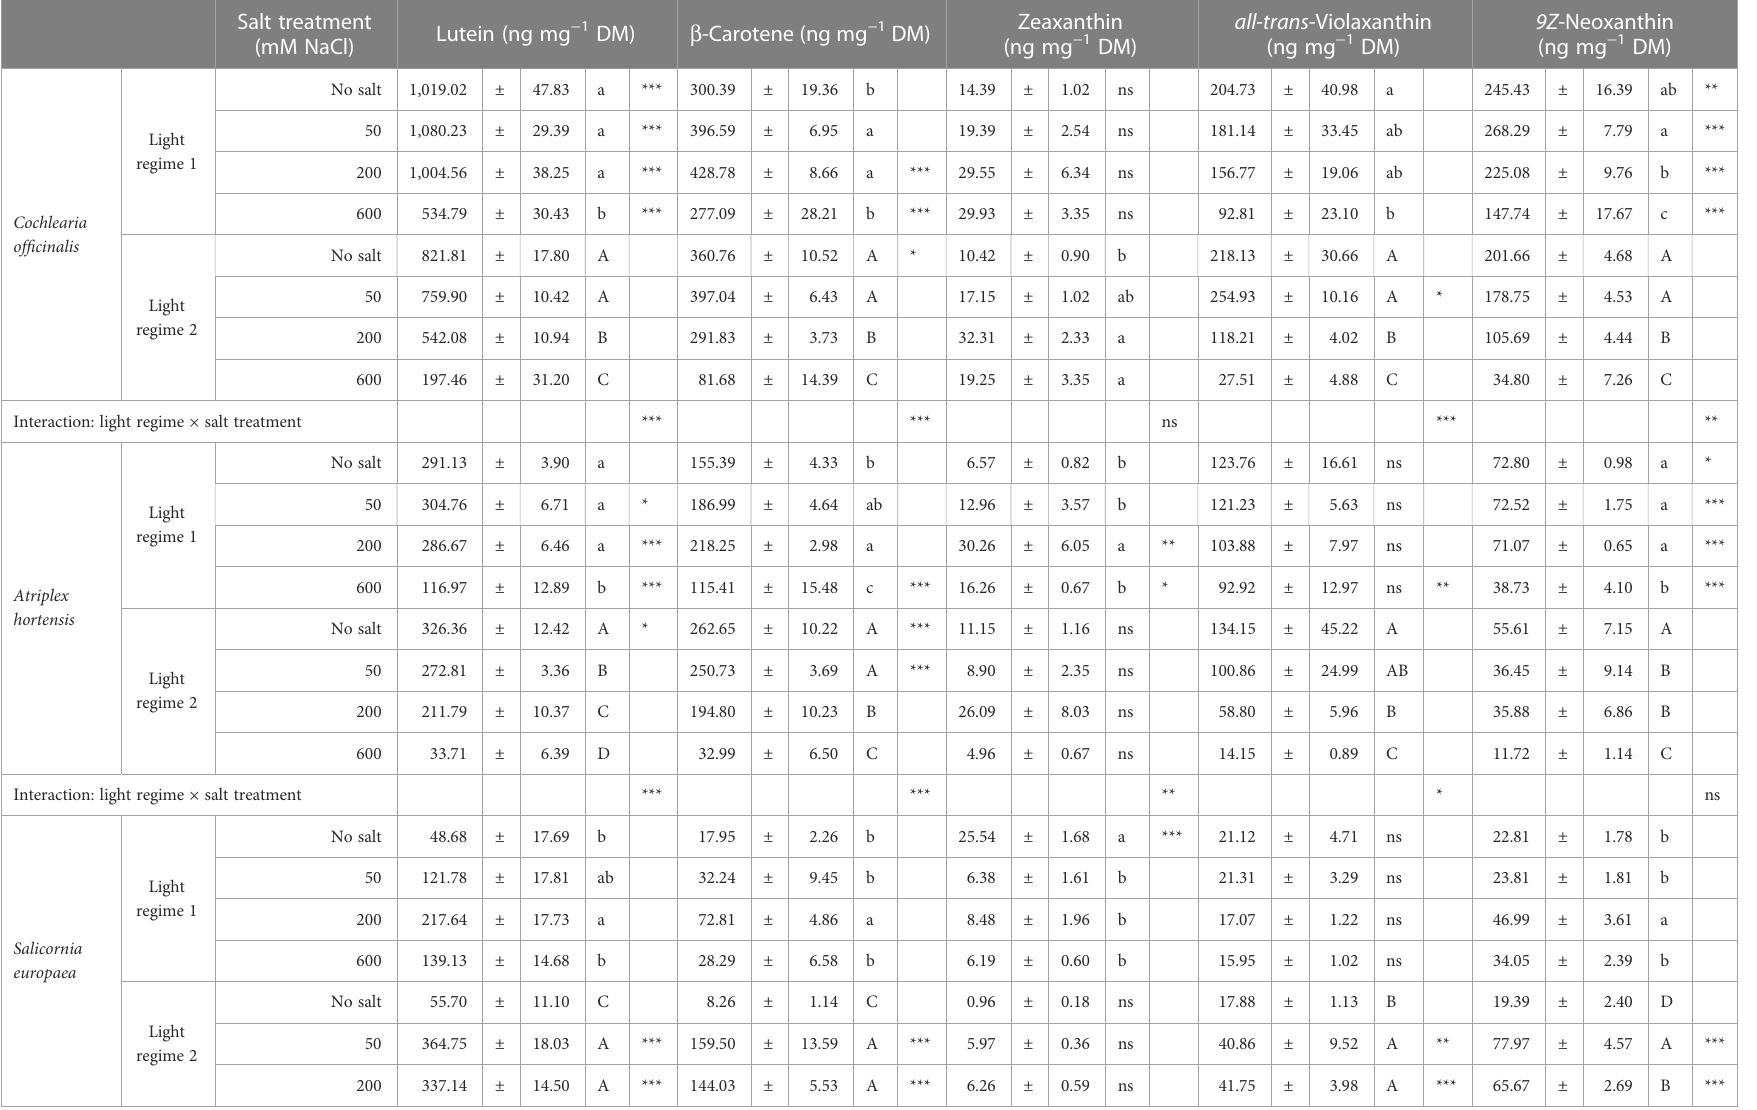
TABLE 3 Content of carotenoids on a dry mass basis in the leaves of 6- to 9-week-old plants (means ±